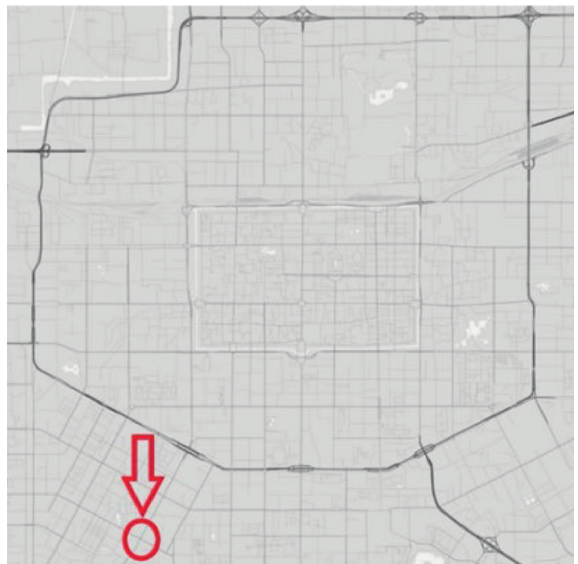
Figure 2: The location of the investigated intersection. The in- vestigated intersection is a traditional cross